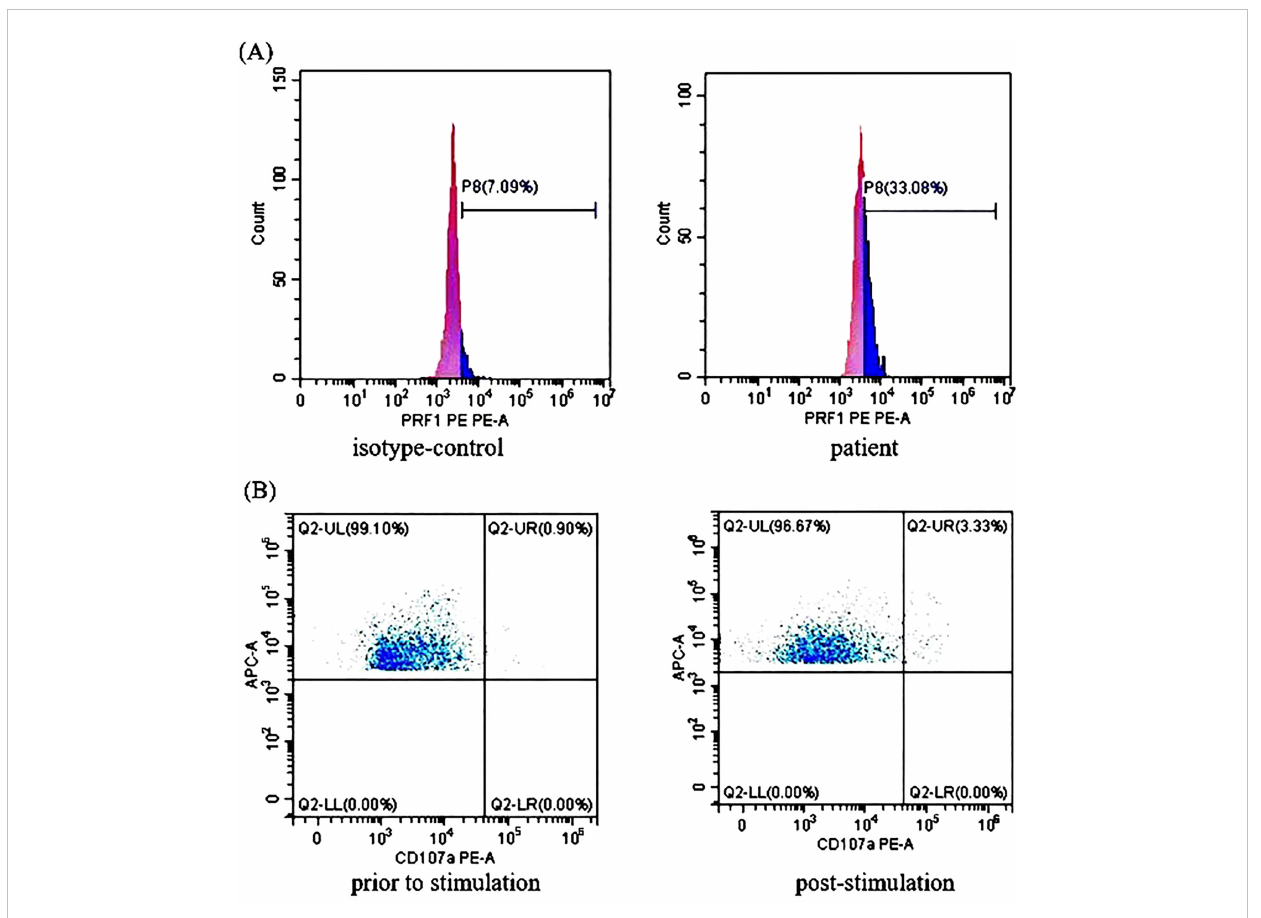
FIGURE 2 The perforin protein (PRF1) expression and D CD107a in natural killer (NK) cells of Case 2: (A) Flow cytometry analysis revealed the decreased expression rates of PRF1 in NK cells of Case 2. The expression rates of PRF1 were 7.09% of the negative control and 33.08% of the patient sample. The negative control was treated with isotype-control antibodies to eliminate the false positive interference caused by the non-speci fi c binding of antibodies to the cells. Thus, the actual expression rates of PRF1 were 25.99% (i.e., 33.08% - 7.09% = 25.99%, normal: ≥ 81%). (B) The NK cells stimulation test showed severe dysregulation of the immune response. The expression rates of CD107a in the NK cells of Case 2 were 0.90% (before stimulation) and 3.33% (post-stimulation). Thus, D CD107a was 2.43% ( D CD107a >10% indicates normal degranulation